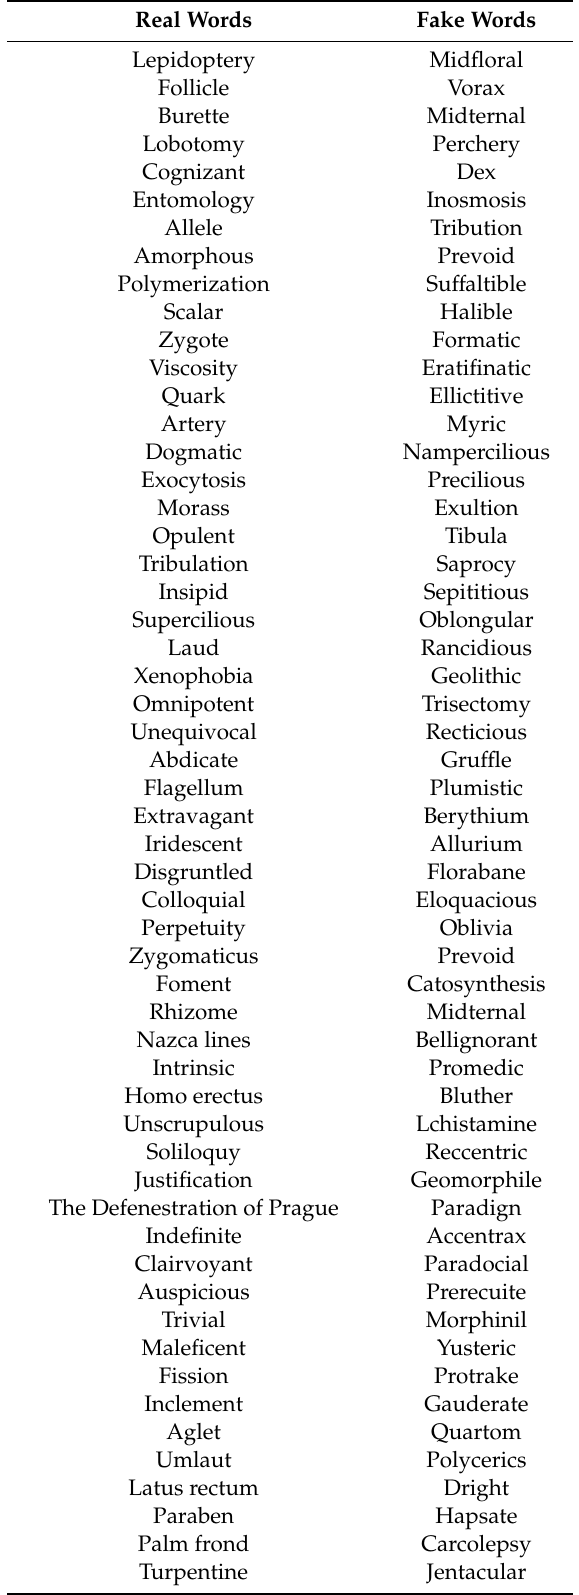
Table A1. List of words used in the